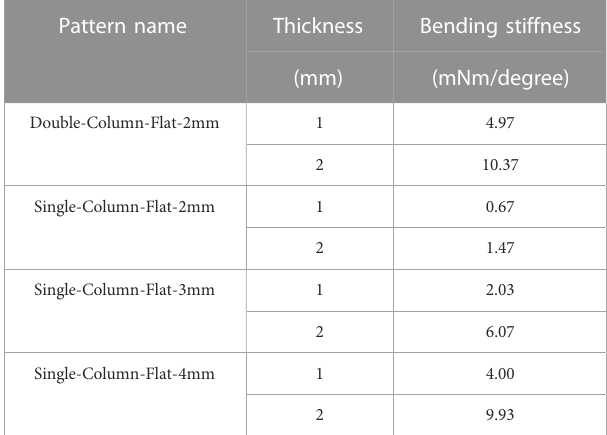
TABLE 6 Experimental bending stiffness of exoskeleton hinge vertebrae with different kirigami-inpsired